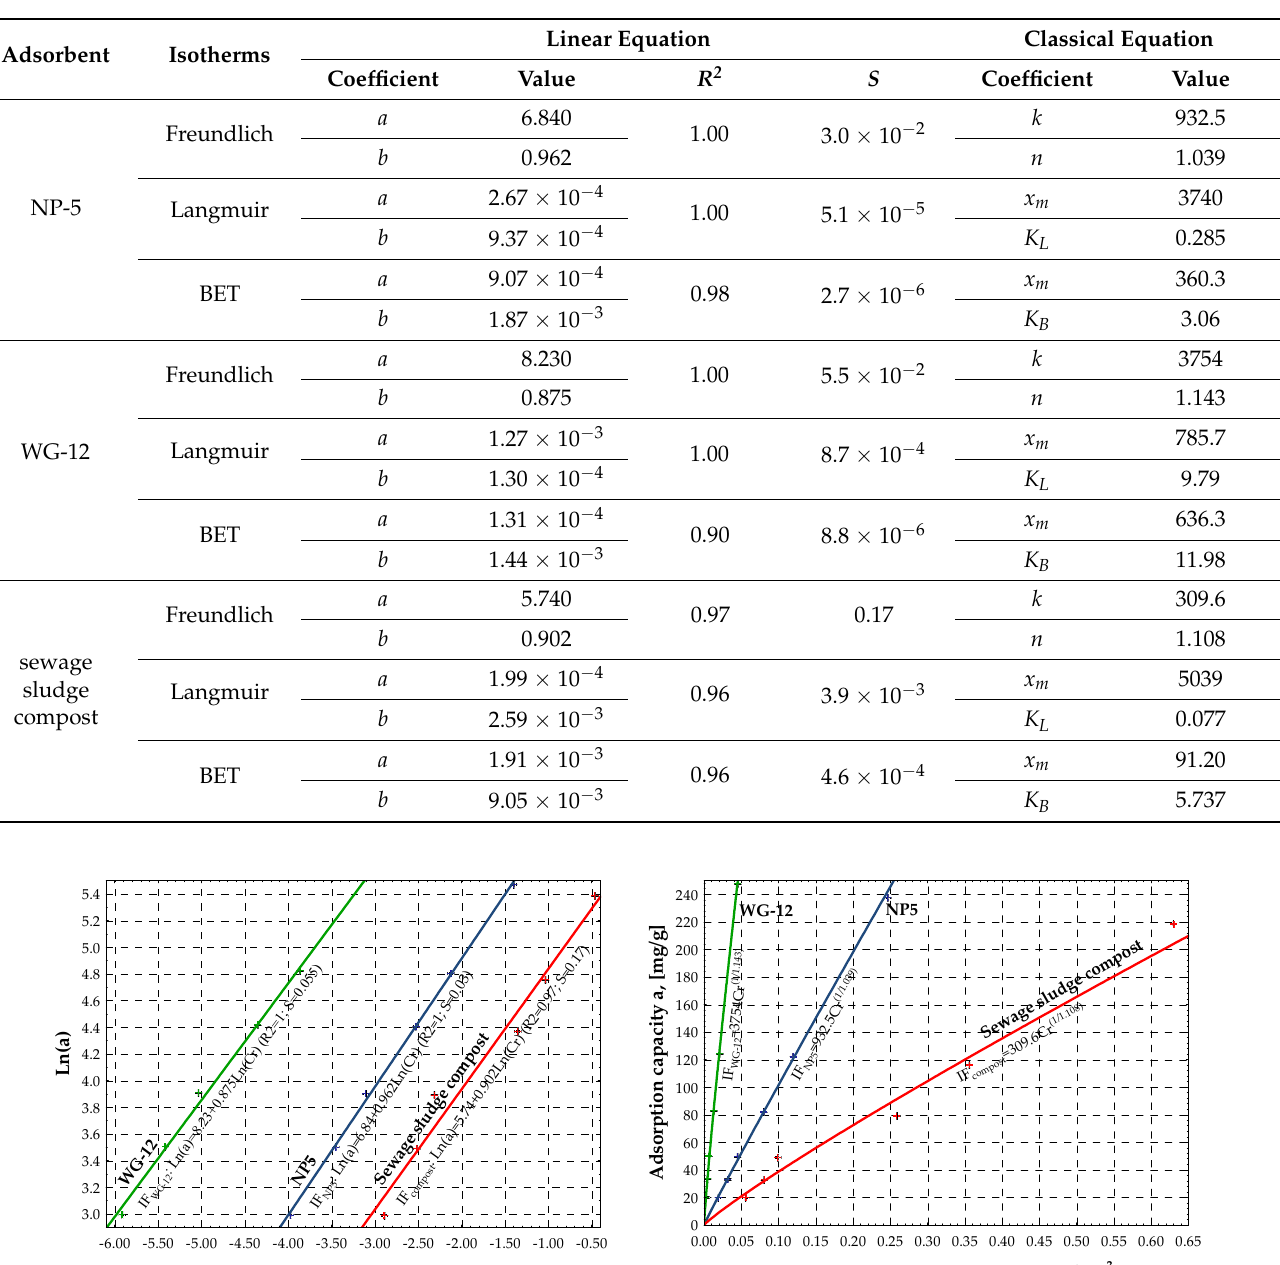
Table 4. Values of linear and classical coefficients of aldrin adsorption isotherms (Freundlich, Lang- muir, and BET) for NP5, WG-12 activated carbons, sewage sludge compost, and the quality of the approximation.